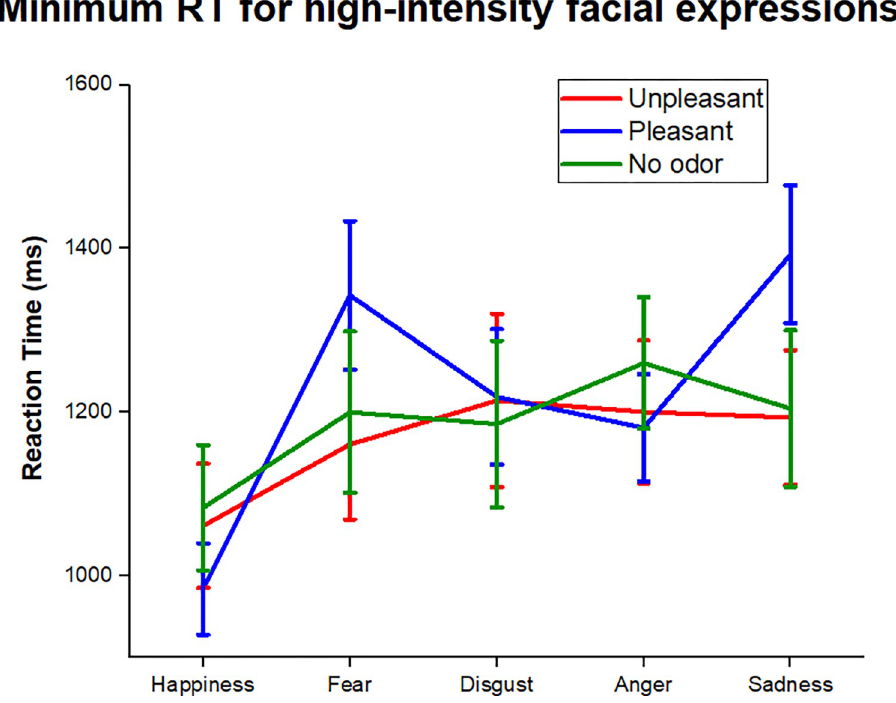
Fig 7. Difference in the minimum RT between emotions in each odor condition. Means and standard errors of the minimum RT for each emotion according to the odor